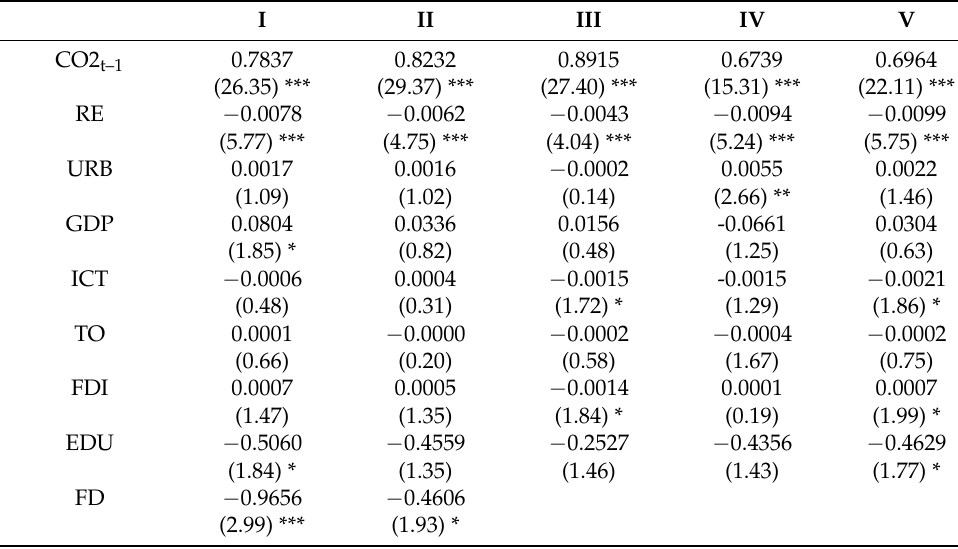
Table 5. CO 2 emissions (kg per 2010 USD of GDP): additional